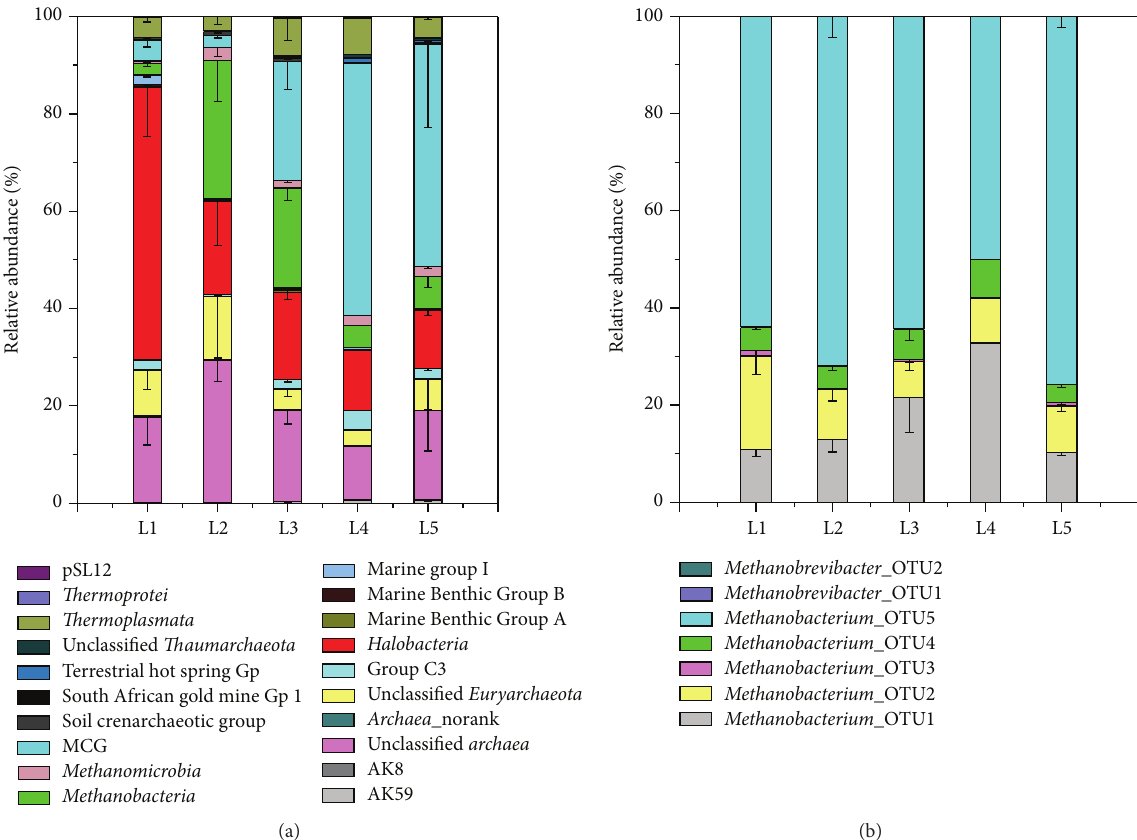
Figure 1: (a) Archaeal community composition of the five sediment layers at the class level (Miscellaneous Crenarchaeotic Group: MCG). Class Methanobacteria was included in this figure; (b) composition of Methanobacteria at OTU level; bars indicate the standard deviations of the technical replicates.